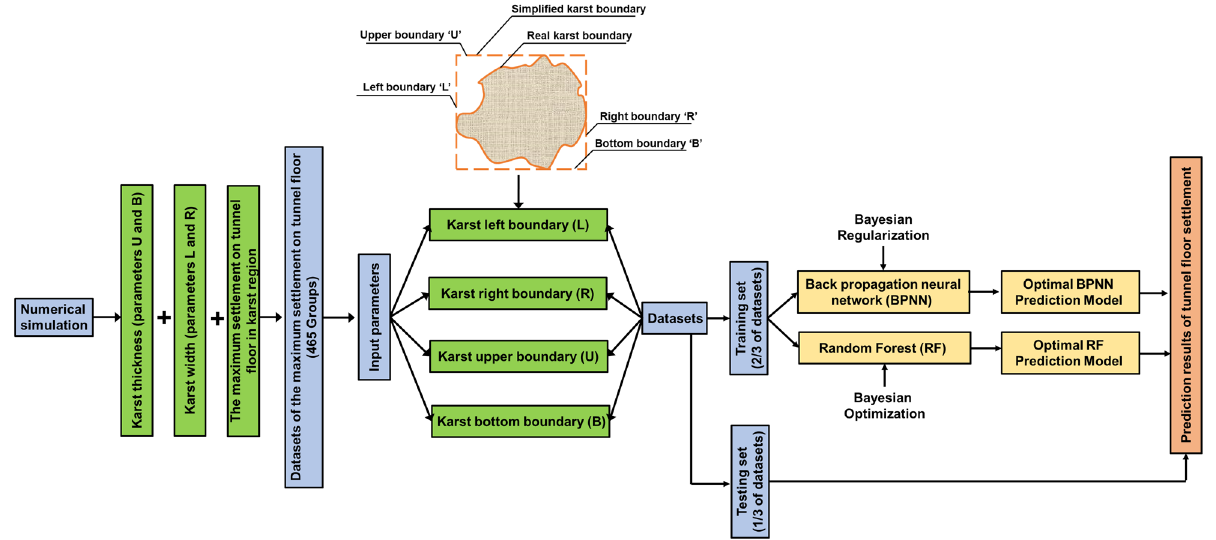
Figure 2. BPNN and BF model predicting